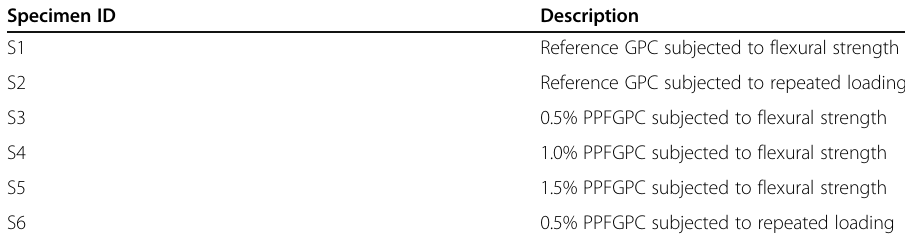
Table 4 Specimen nomenclature and